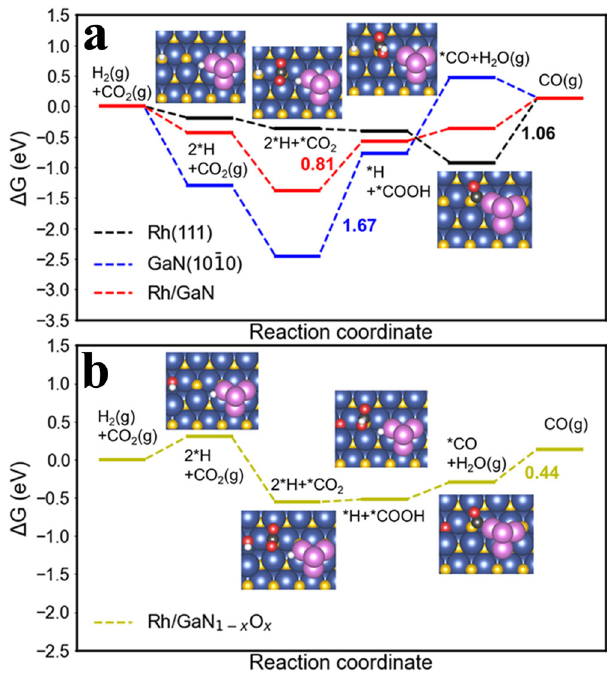
Fig. 5 Theoretical calculations. Reaction energy pro fi le for CO 2 hydrogenation on a Rh (111), GaN (10 (cid:1) 10), Rh/GaN and b Rh/GaN 1 – x O x . The values in the fi gures are indicative of the energy barriers for the potential- determining step of the reaction. Ga, blue; N, yellow; Rh, purple; C, black; H, white; and O, red.